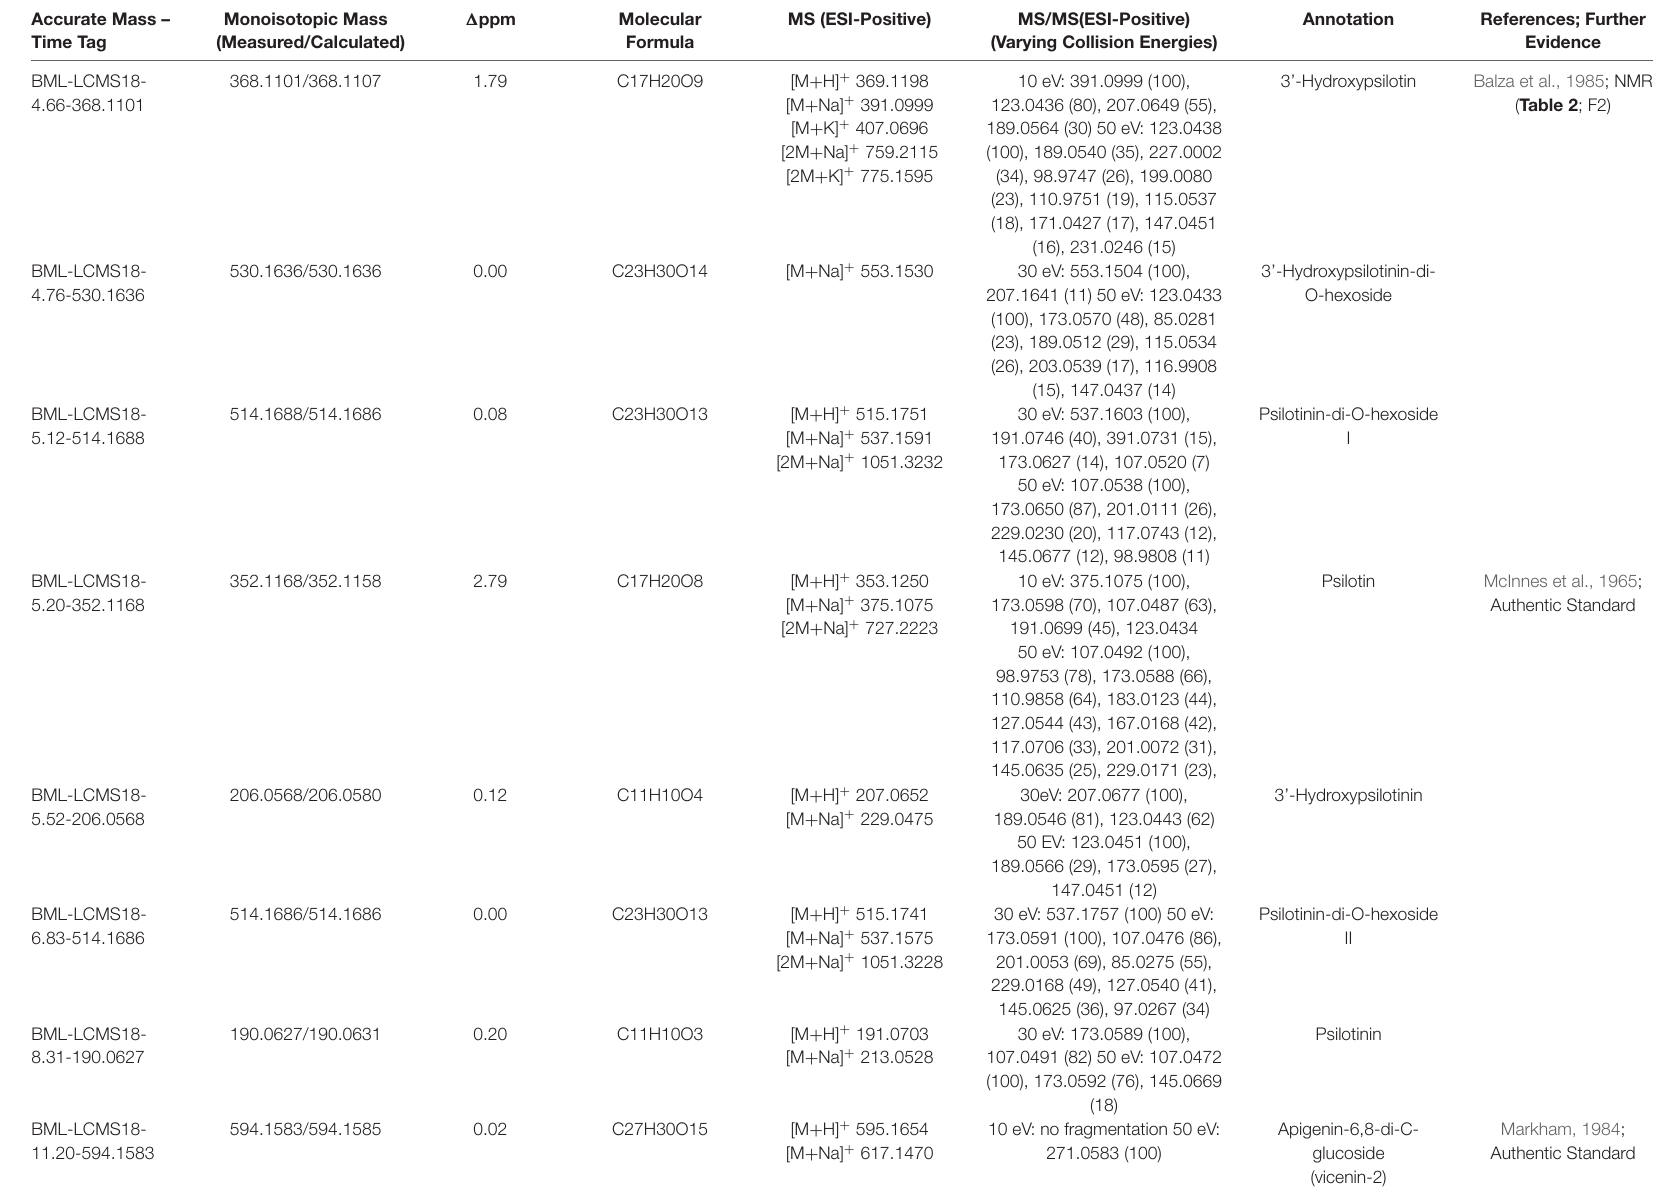
TABLE 1 | Annotation of HPLC-QTOF-MS